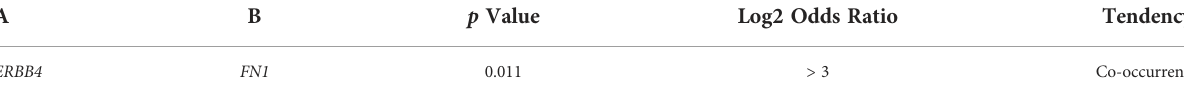
TABLE 4 Mutual exclusivity analysis of selected genes in metastatic breast cancer study.